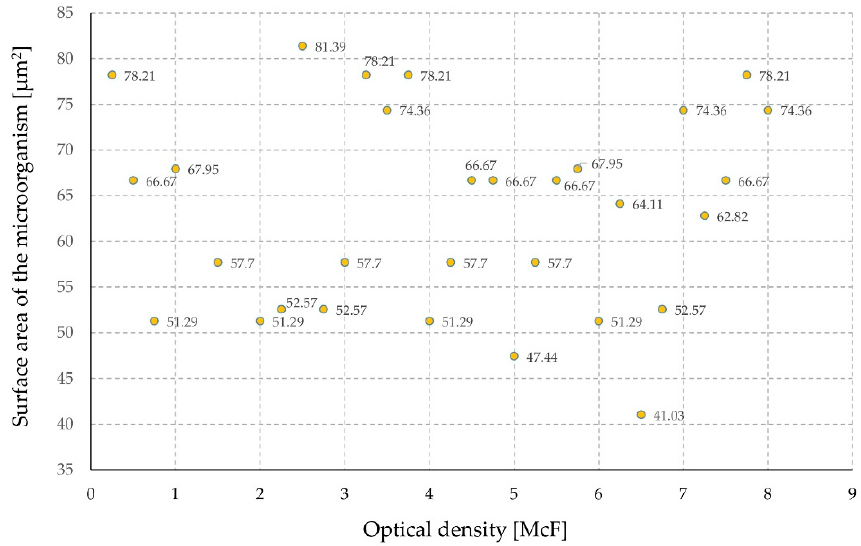
Figure 8. The surface area of the microorganism in relation to the optical density of the suspension.